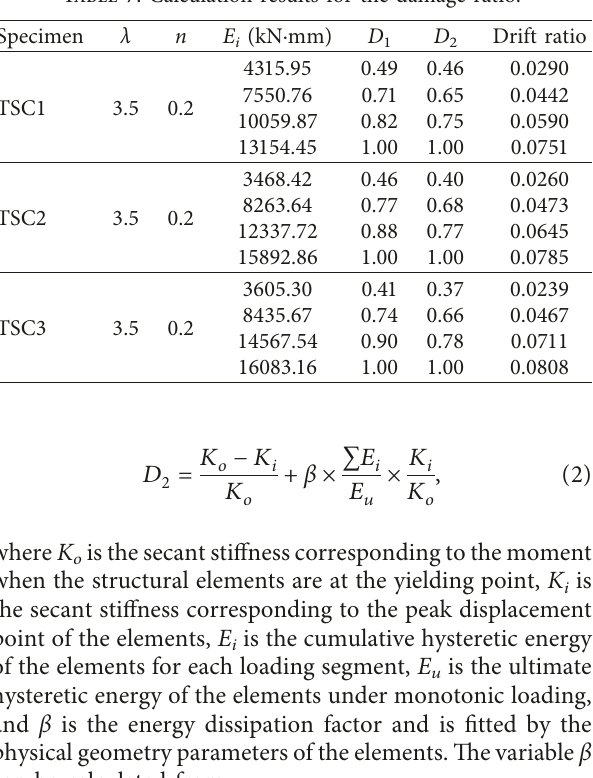
Figure 11: Secant stiffness degradation coefficient curves of the specimens. Table 7: Calculation results for the damage ratio.